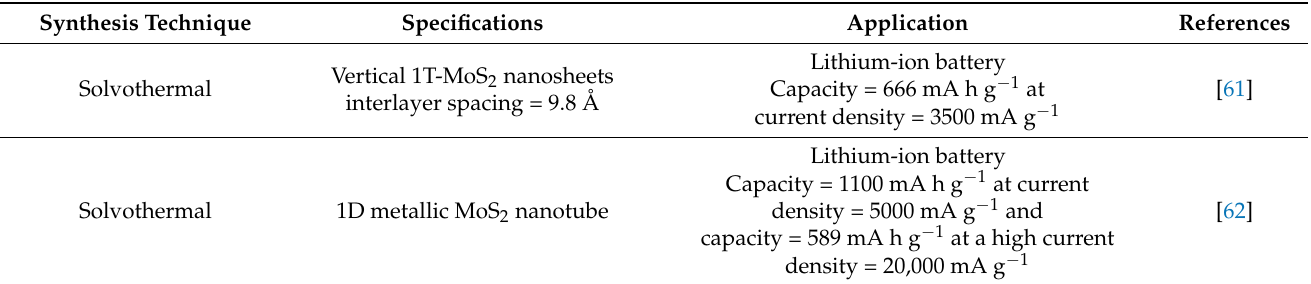
Table 1. Solvothermal and hydrothermal synthesis techniques and their applications. Synthesis